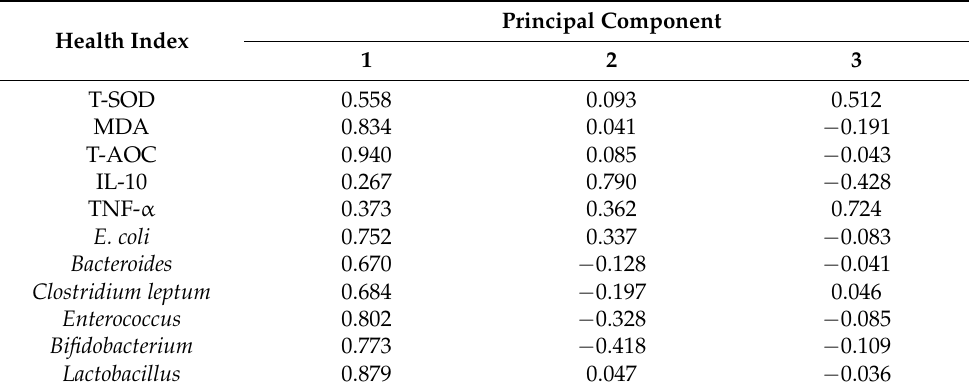
Table 5. The factor load matrix of the principal component on each health